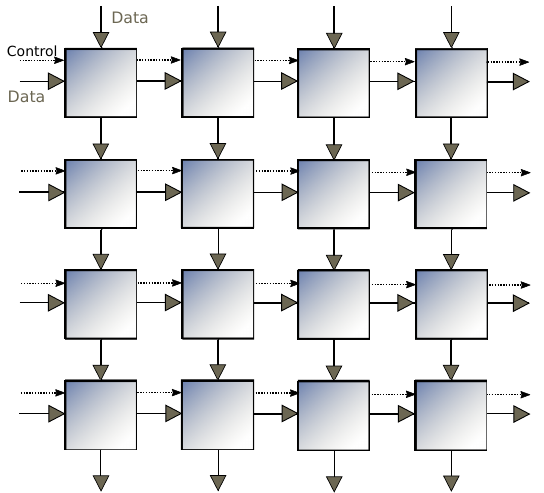
Figure 2. Two-dimensional